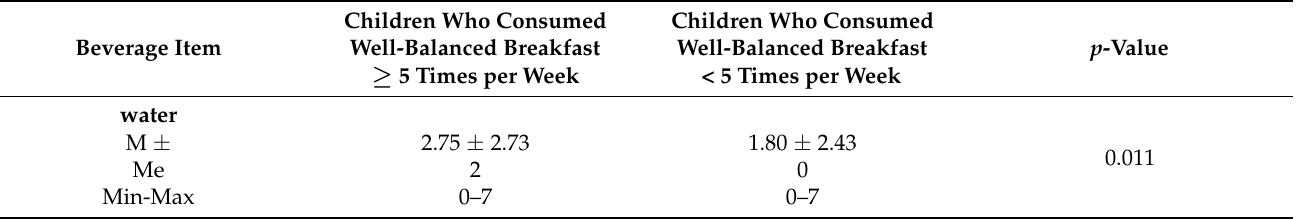
Table 6. Consumption frequency of selected beverage items for breakfast during the week in group of children who consumed well-balanced breakfast 5 or more days per week or less than 5 days per